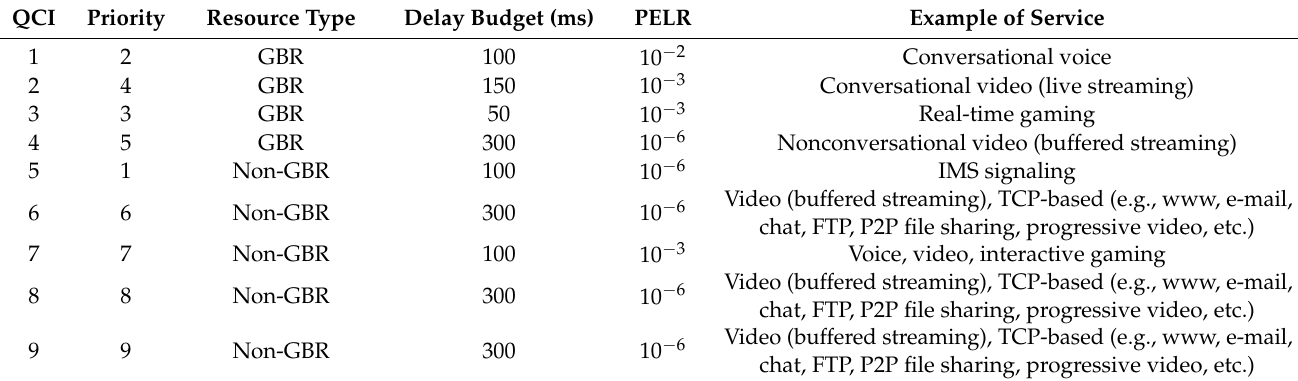
Table 5. QCI values and corresponding parameters in LTE network